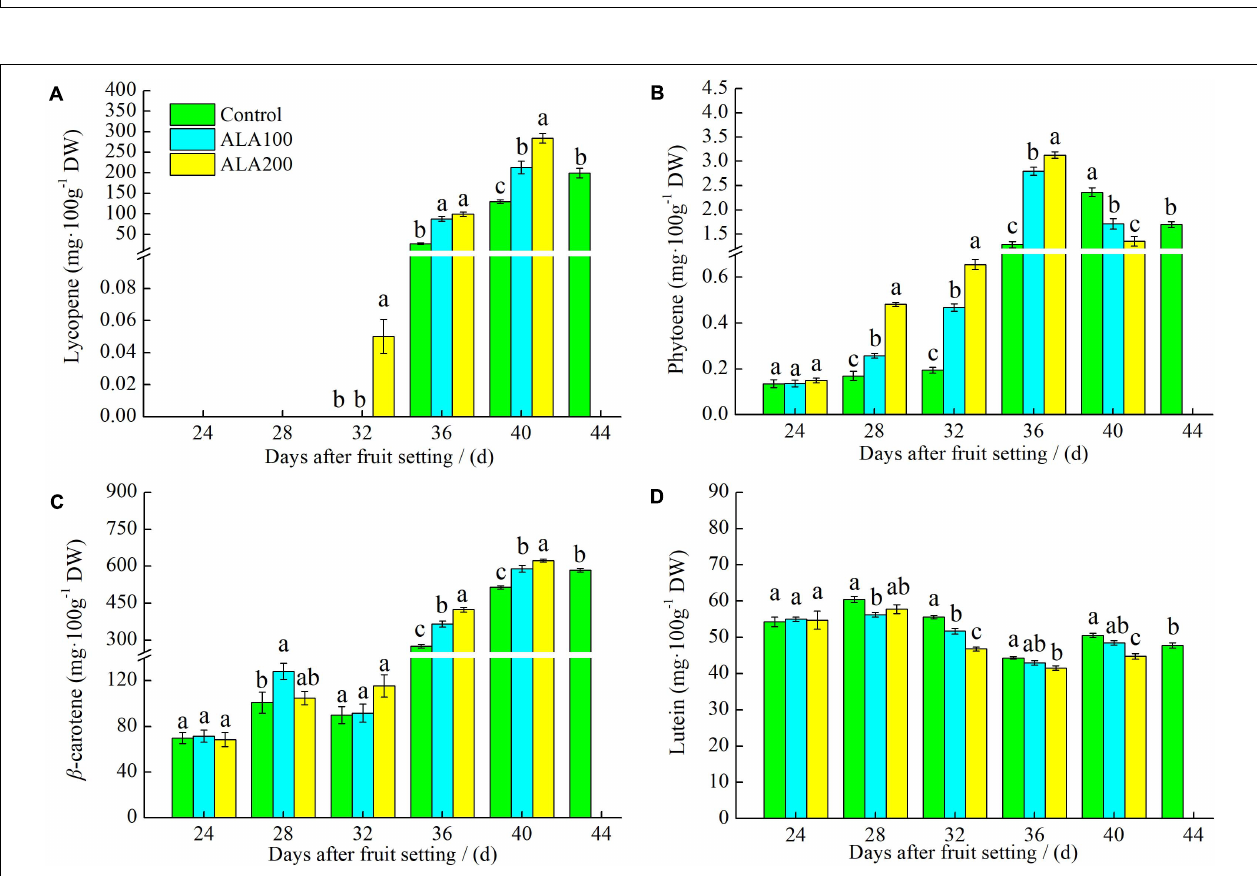
FIGURE 4 | The effects of ALA on the intermediates in lycopene synthesis and metabolic pathway. (A) Lycopene content; (B) the phytoene content; (C) the β -carotene content; and (D) the lutein content of tomato fruits at 24th–44th day after fruit setting under different treatments. The 44th day after fruit setting data of the control group and the 40th day after fruit setting data of other treatments were analyzed by analyzed by analysis of variance (ANOVA) to separate its significance. Vertical bars represent mean ± SE from three independent replicates and the different letters denote significant differences ( p < 0.05).